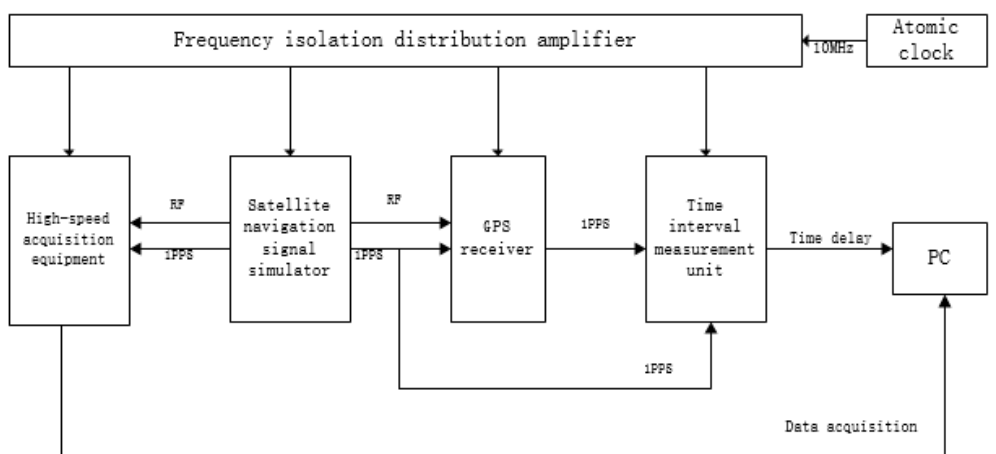
Figure 5. Schematic setup for the absolute calibration of a GPS receiver.